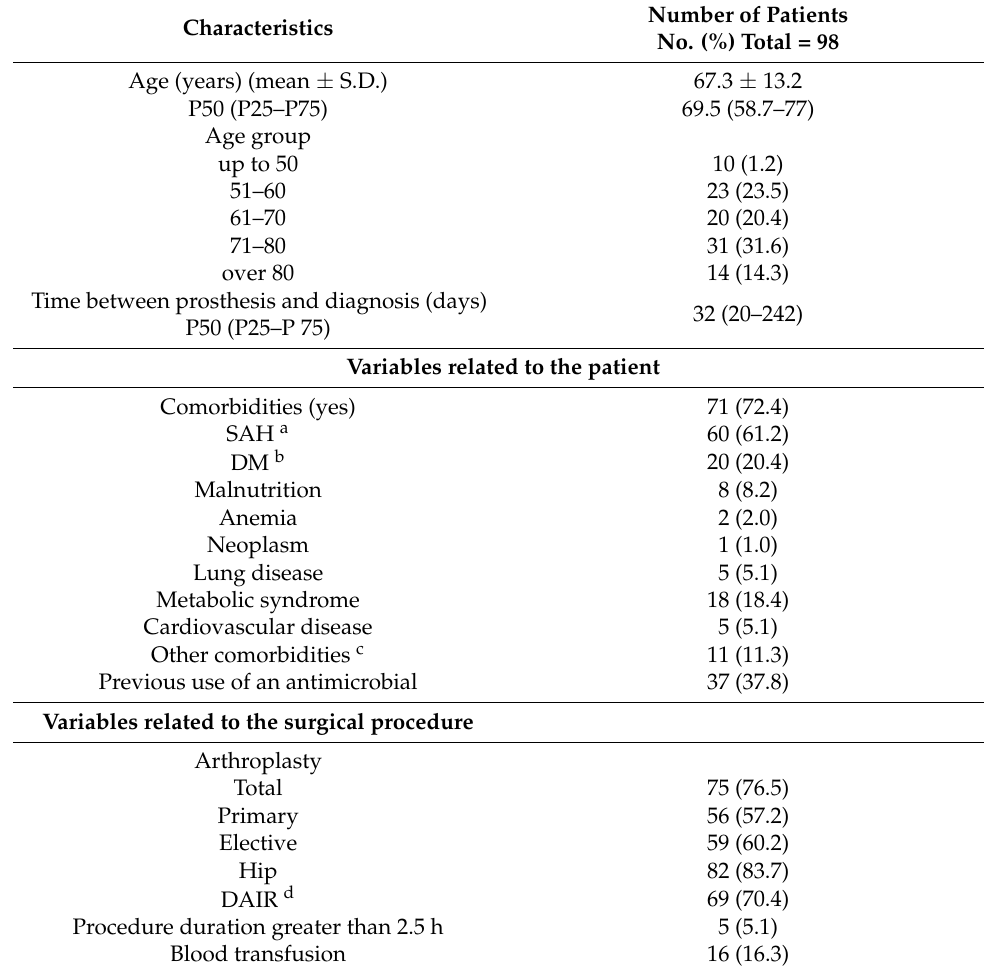
Table 1. Demographics and clinical characteristics of the study population.